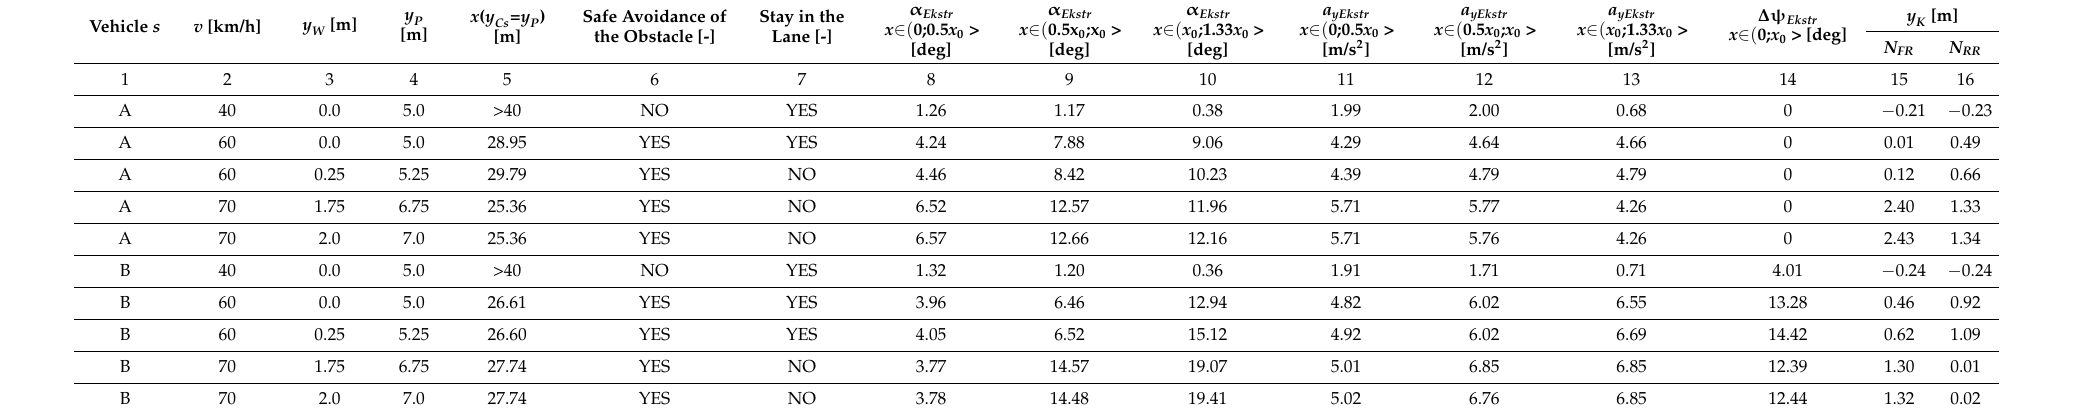
Table 1. Fragment of a set of results of simulations of CT unit’s motion during an obstacle avoidance